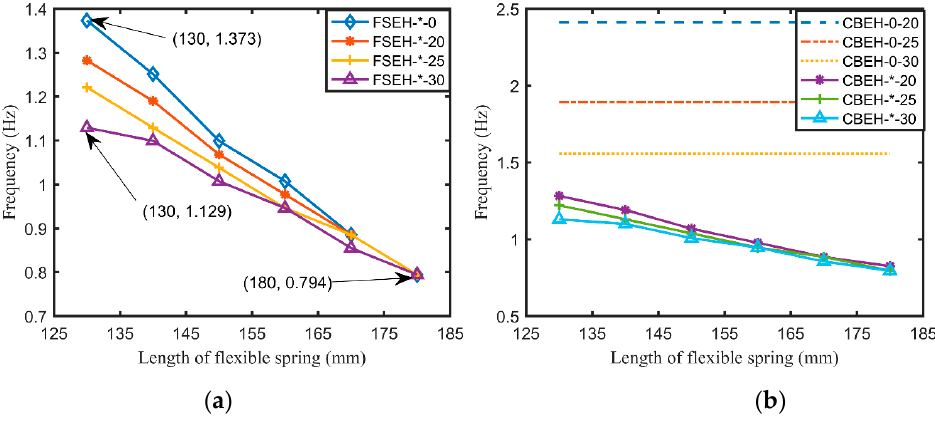
Figure 8. Fundamental oscillation frequency of various harvesters as a function of the length of the flexible spring at 10.52 m / s: ( a ) FSEH; and ( b ) CBEH.